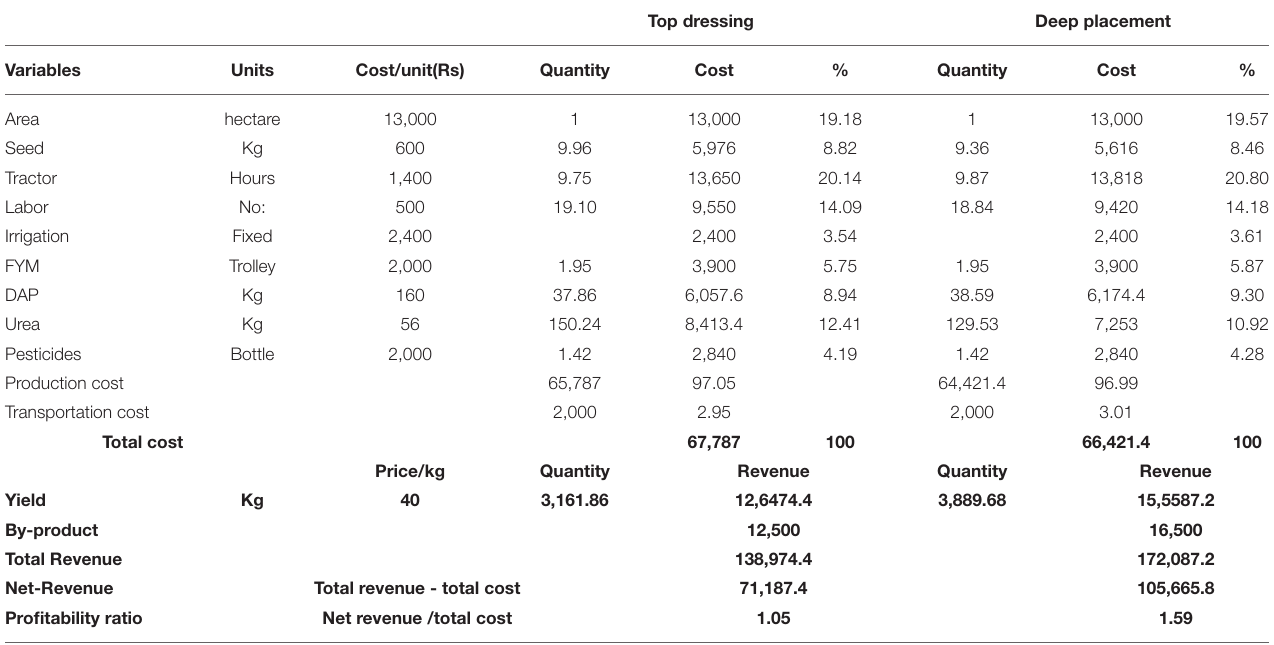
TABLE 3 | Average cost and net return of maize (per hectare).